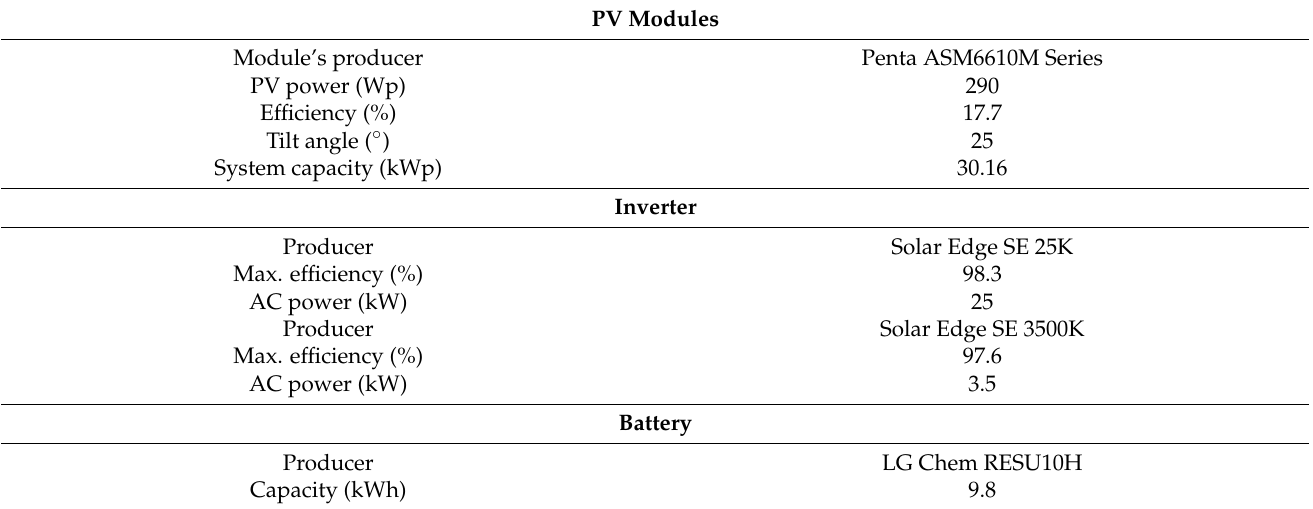
Table 3. Main parameters of the hybrid PV system